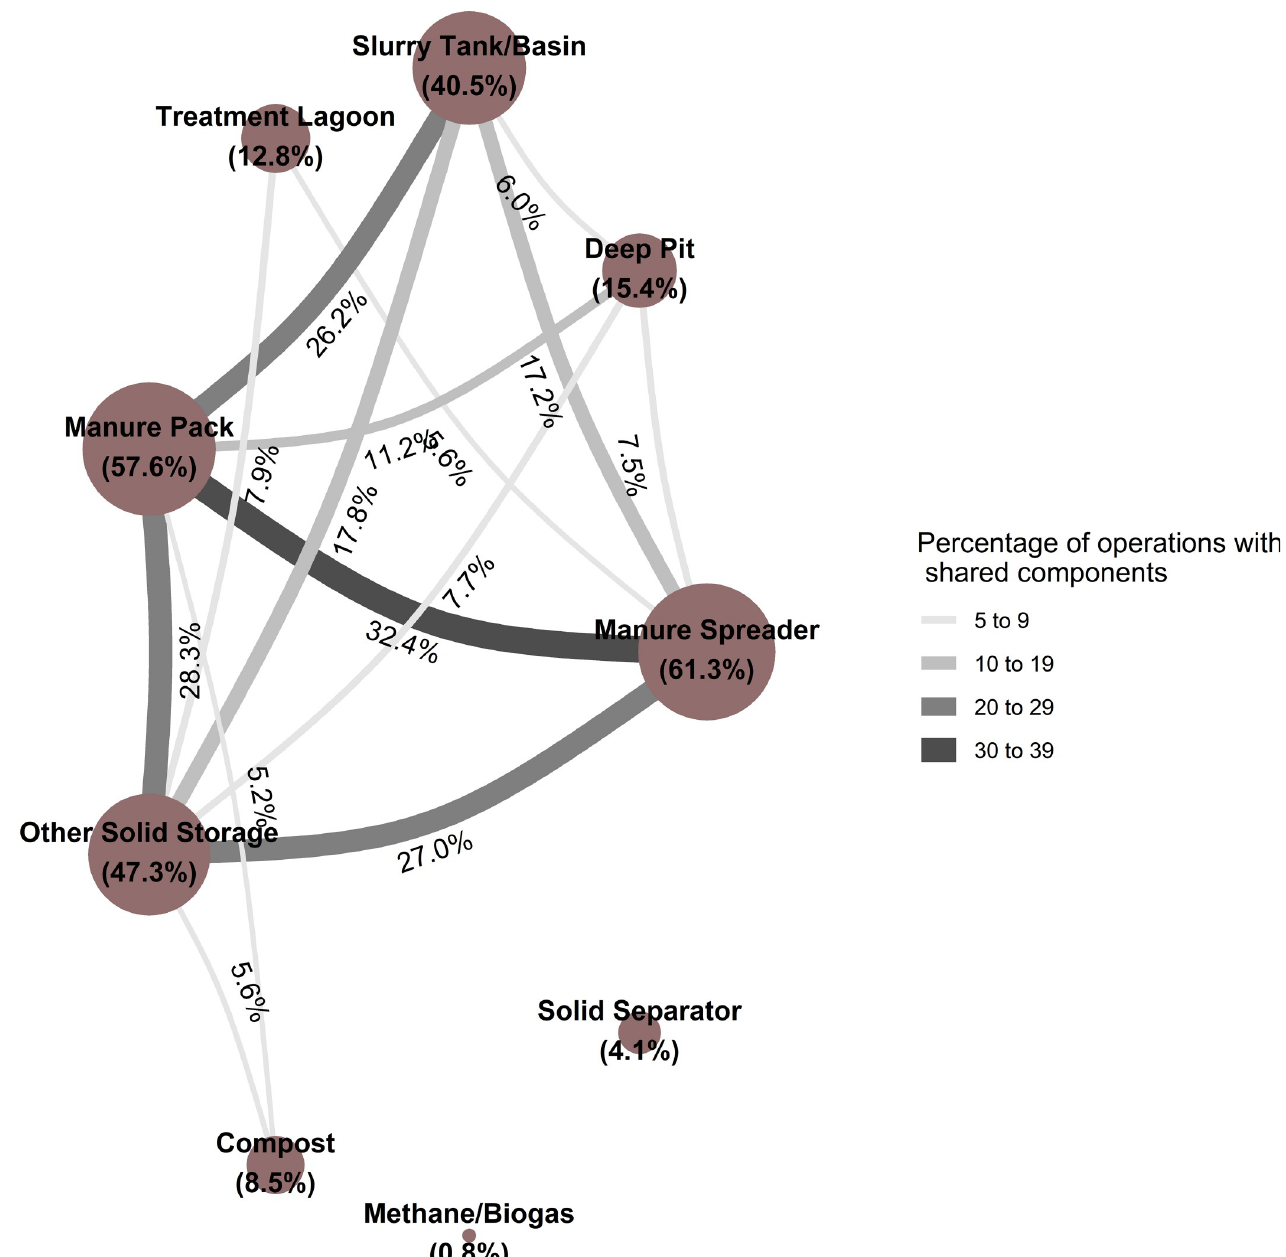
Fig 2. Network graph showing the percentage of operations practicing the given manure storage strategy (diameter of nodes) and the percentage of operations practicing a pair of strategies together (width of edges, with widths colored by group based on magnitude of percentage). Edges representing percentages of five or less were